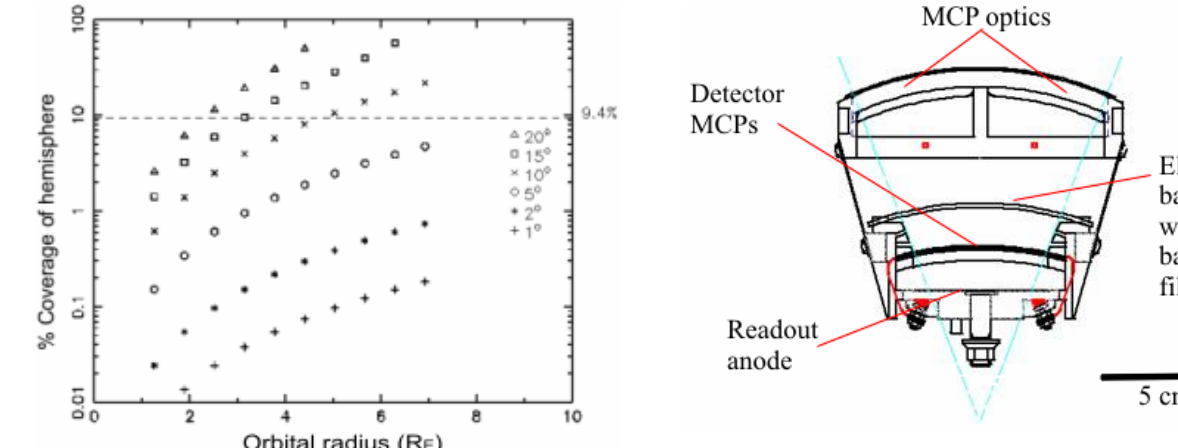
orbital radius for FOV values between 1 ◦ and 20 ◦ . The dashed proximate scale between 1º and 20º. The dashed line indicates a coverage of 9.4%, equivalent to the auroral the curved elements shown here. Approximate scale indicated. line indicates a coverage of 9.4%, equivalent to the auroral oval oval (Ruohoniemi and Baker, 1998). Orbital radius is expressed in Earth radii, measured from (Ruohoniemi and Baker, 1998). Orbital radius is expressed in Earth